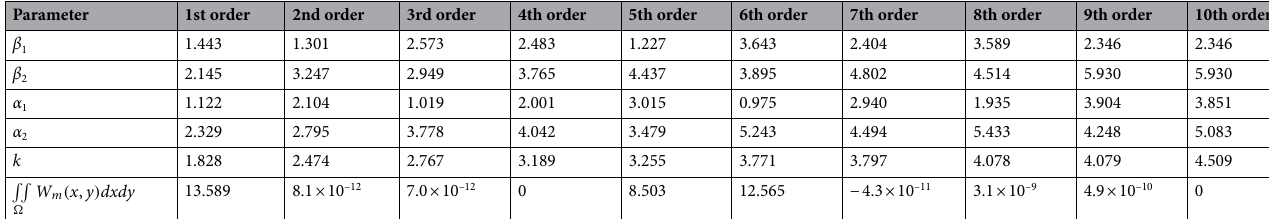
Table 1. The first 10 vibration modal parameters of single-layered thin plate rock mass.